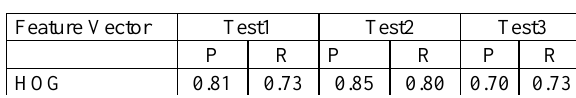
Table 2. Accuracy of SIFT-SPMK methods